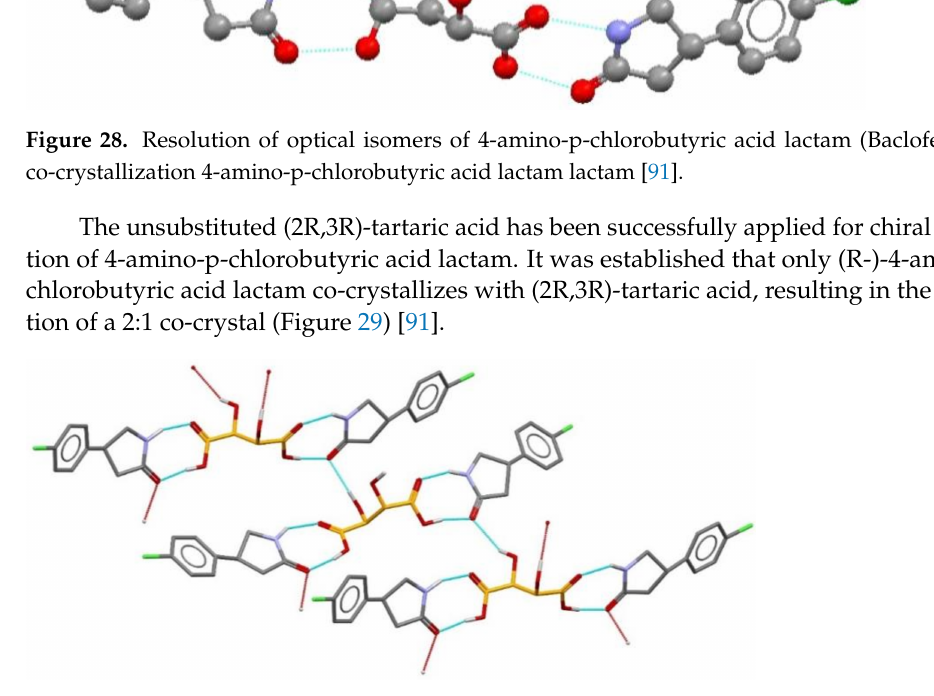
Figure 29. The 2:1 co-crystal of (R-)-4-amino-p-chlorobutyric acid lactam with (2R,3R)-tartaric acid [91].